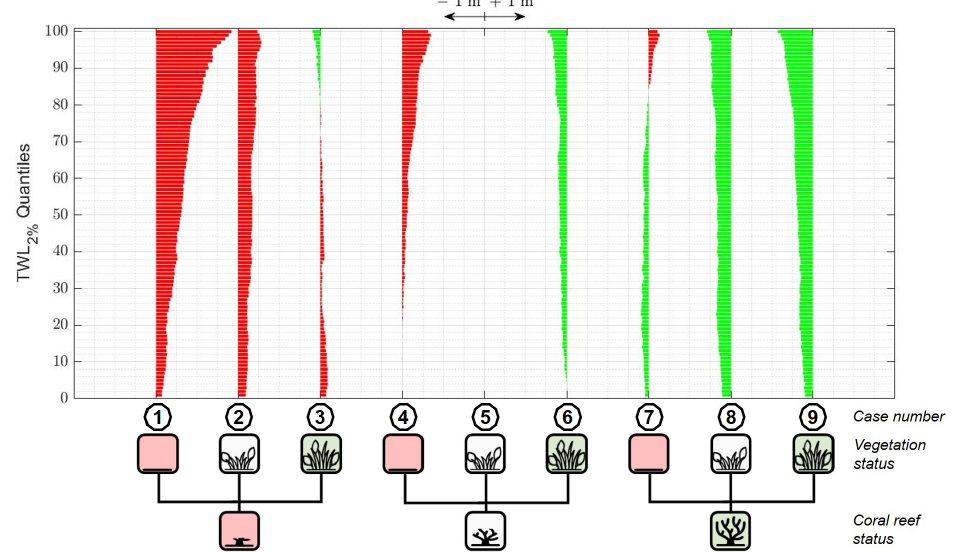
Figure 7. TWL 2% differences against reference configuration expressed with quantiles. Values greater than reference are represented in red and values lower than reference in green. Each ecosystem configuration is presented, pictograms represent the status of the ecosystem. The arrows give the scale of a difference of one meter on the X